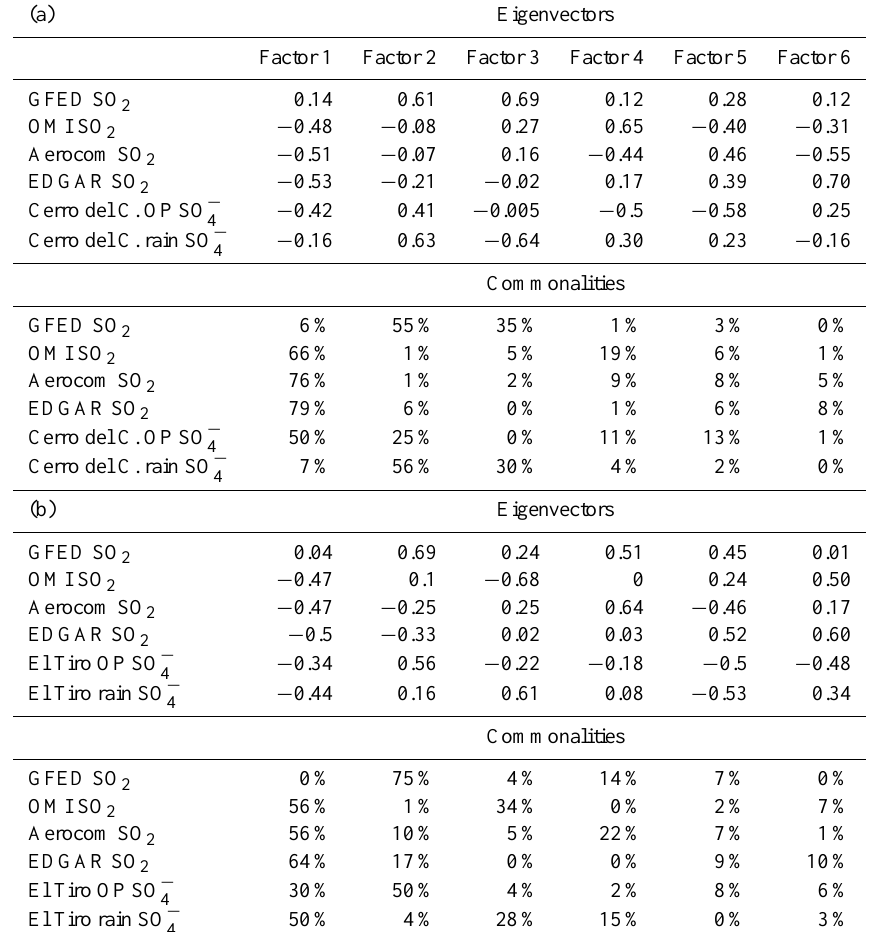
Table 4. Eigenvectors and commonalities from factor analysis with varimax rotation, where (a) shows the results of the data aggregated according to Cerro del Consuelo meteorological station (MS) sample collection dates and (b) those for El Tiro